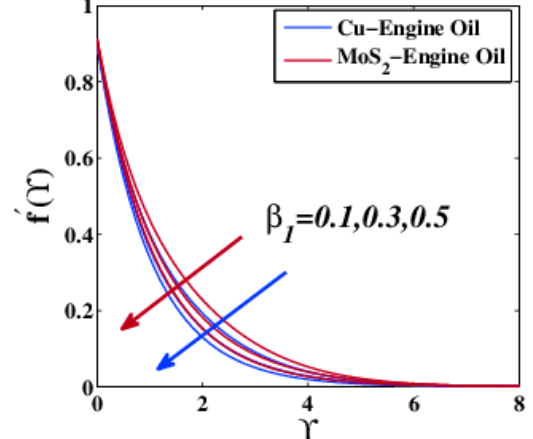
Figure 4. The effect of β 1 on velocity variation f (cid:48) ( Y ) .